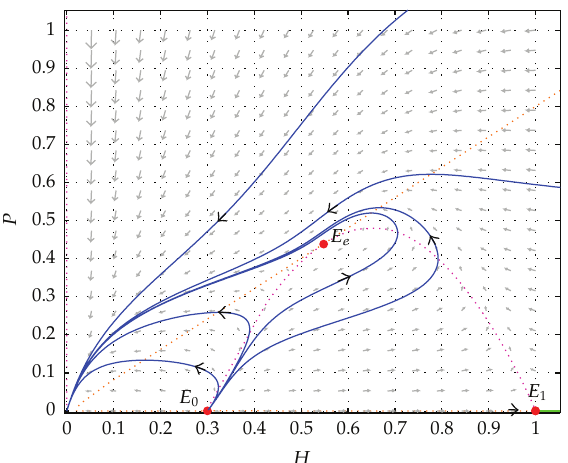
Figure 3: The phase portrait of model (7) with the strong Allee effect. The parameters are taken as 𝑎 = 0.2556936062 , 𝛿 = 0.8 , = (0.3, 0) is an unstable 𝑚 = 1.3 , and 𝑟 = 0.07238979895 . 𝐸 0 node point; 𝐸 1 = (1,0) is saddle point; the positive equilibrium = (0.2, 0.4) is a cusp point. In this case, the point (0, 0) is globally 𝐸 2 asymptotically stable. The dotted curves are the